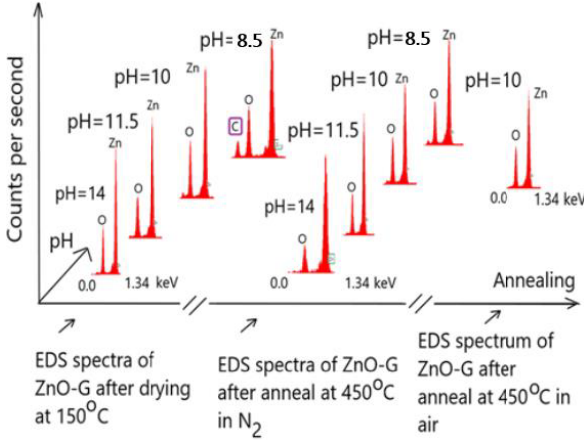
Figure 7: EDS spectra of ZnO-1.4wt% Graphene hybrids as a function of different thermal treatments in nitrogen or